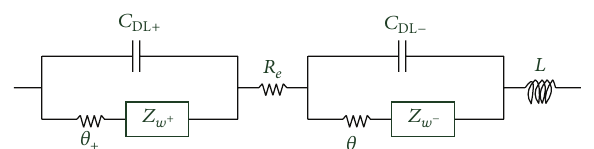
Figure 1: LIBs impedance equivalent circuit